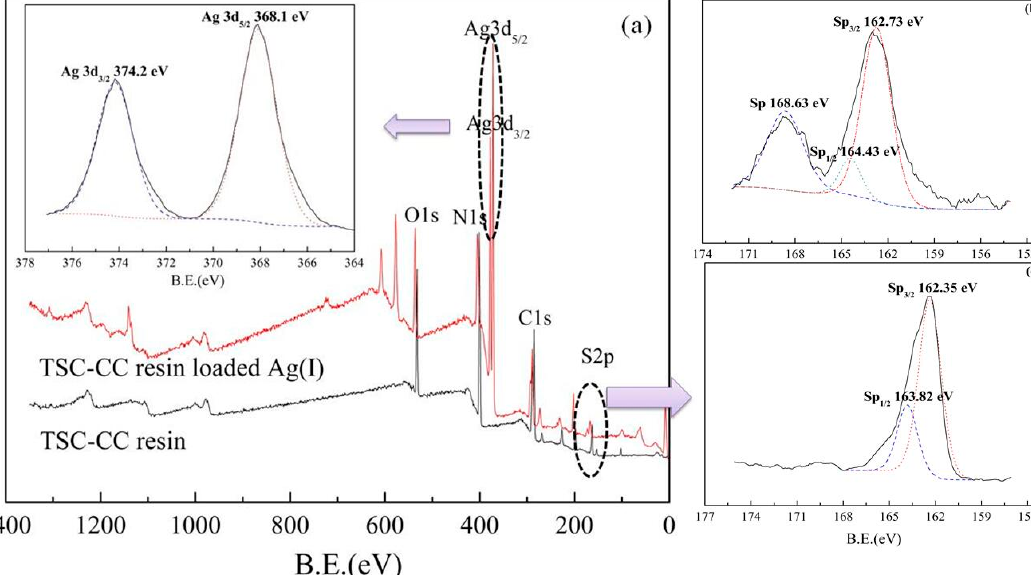
Figure 12. X-ray photoelectron spectroscopy (XPS) core-lever spectra of ( a ) TSC-CC resin before and after Ag + adsorption; ( b ) S 2p after Ag + adsorption; ( c ) S 2p before Ag + adsorption.